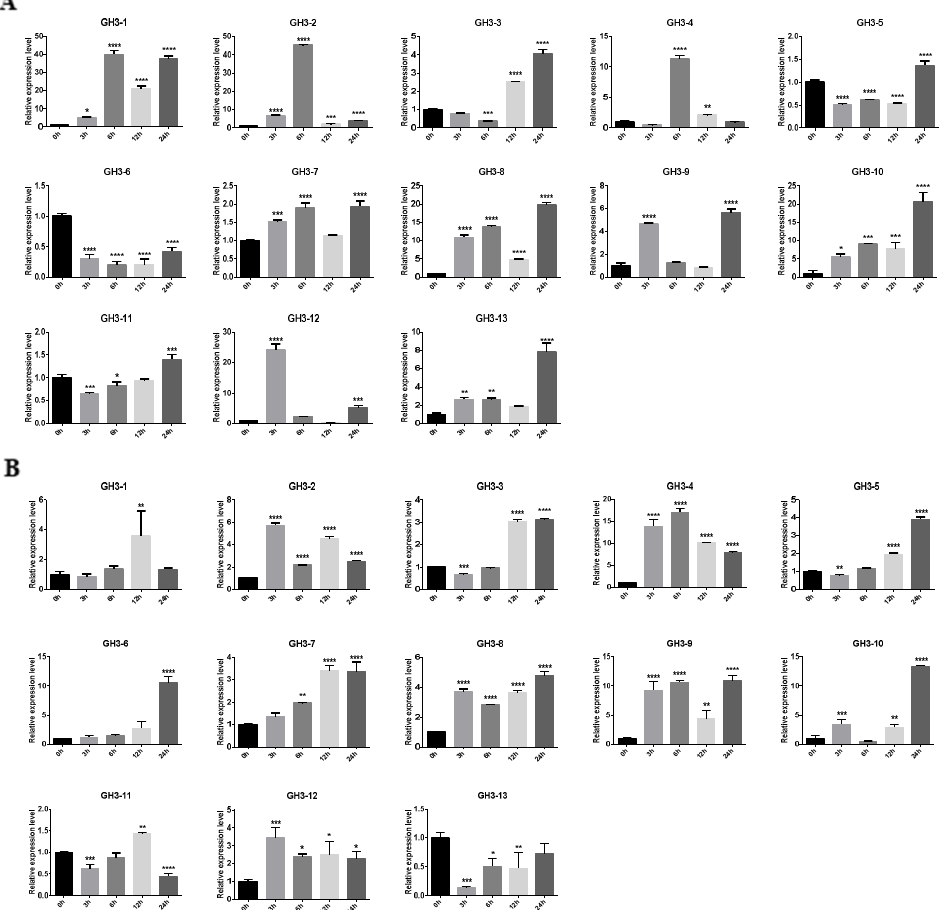
Figure 8. The expression pattern of the 13 OsGH3 genes in ‘Nipponbare’ seedling leaf ( A ) and root ( B ) after NaCl treatment for 0 h, 3 h, 6 h, 12 h, and 24 h. The 2 − ∆∆ CT method was adopted to calculate the fold change of OsGH3 gene expression from three biological replicates. The error bars show the standard deviations of the three independent qRT-PCR biological replicates. * represents a significant difference relative to the 0 h group ( p < 0.05).